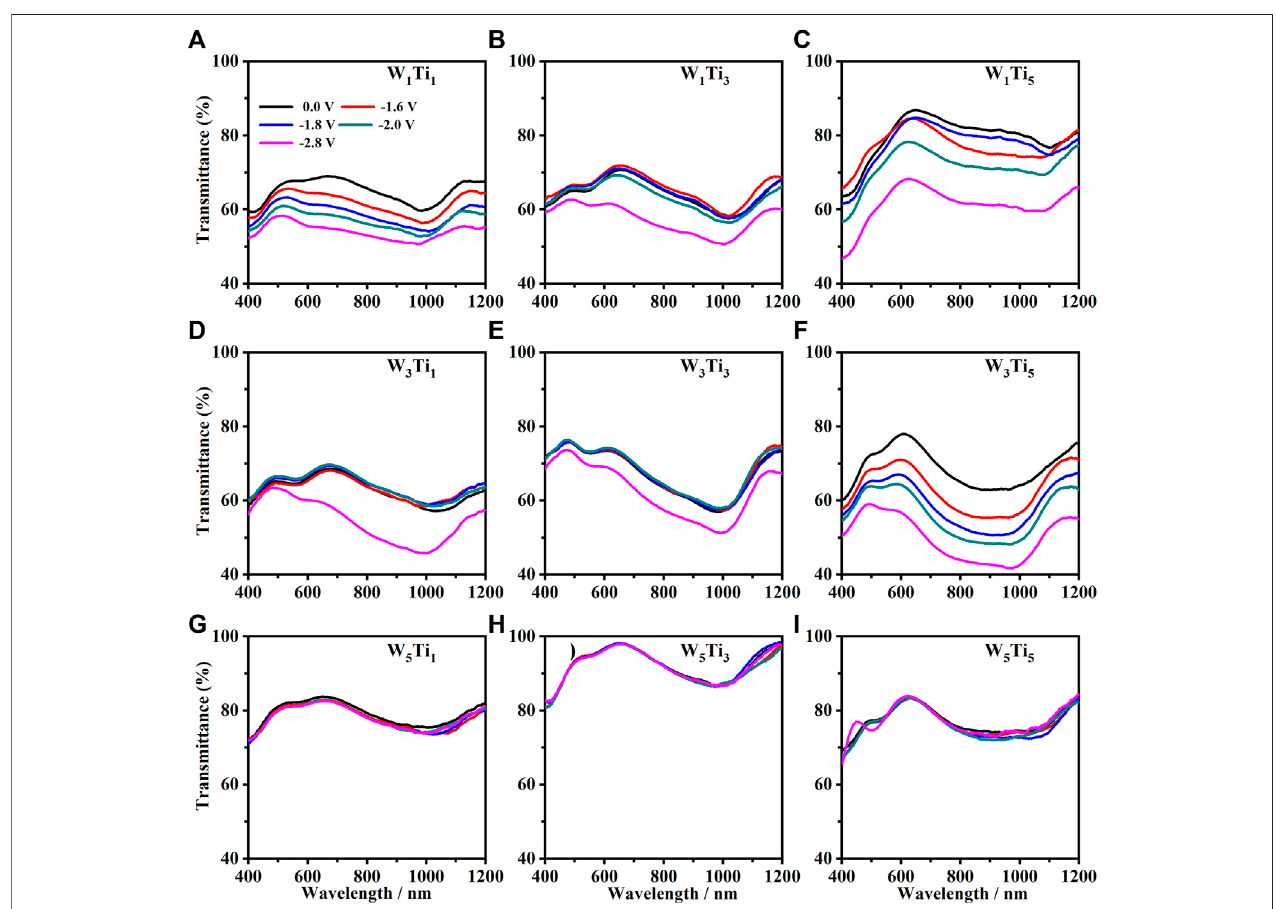
FIGURE4| Opticaltransmittancecurves,intherangebetween400and1200 nm,oftheninefollowingelectrochromicdevices: (A) W 1 Ti 1 , (B) W 1 Ti 3 , (C) W 1 Ti 5 , (D) W 3 Ti 1 , (E) W 3 Ti 3 , (F) W 3 Ti 5 , (G) W 5 Ti 1 , (H) W 5 Ti 3 and (I) W 5 Ti 5 . (W x Ti y where W and Ti indicate the WO 3 and TiO 2 electrodes, respectively and the subscripts x and y indicate their annealing temperature expressed in hundreds, respectively.) The black line corresponds to the 0.0 V (no voltage applied, state OFF). The red, blue, green and magenta lines correspond to the following states ON at − 1.6 V, − 1.8 V, − 2.0 V and − 2.8 V applied voltage, respectively.